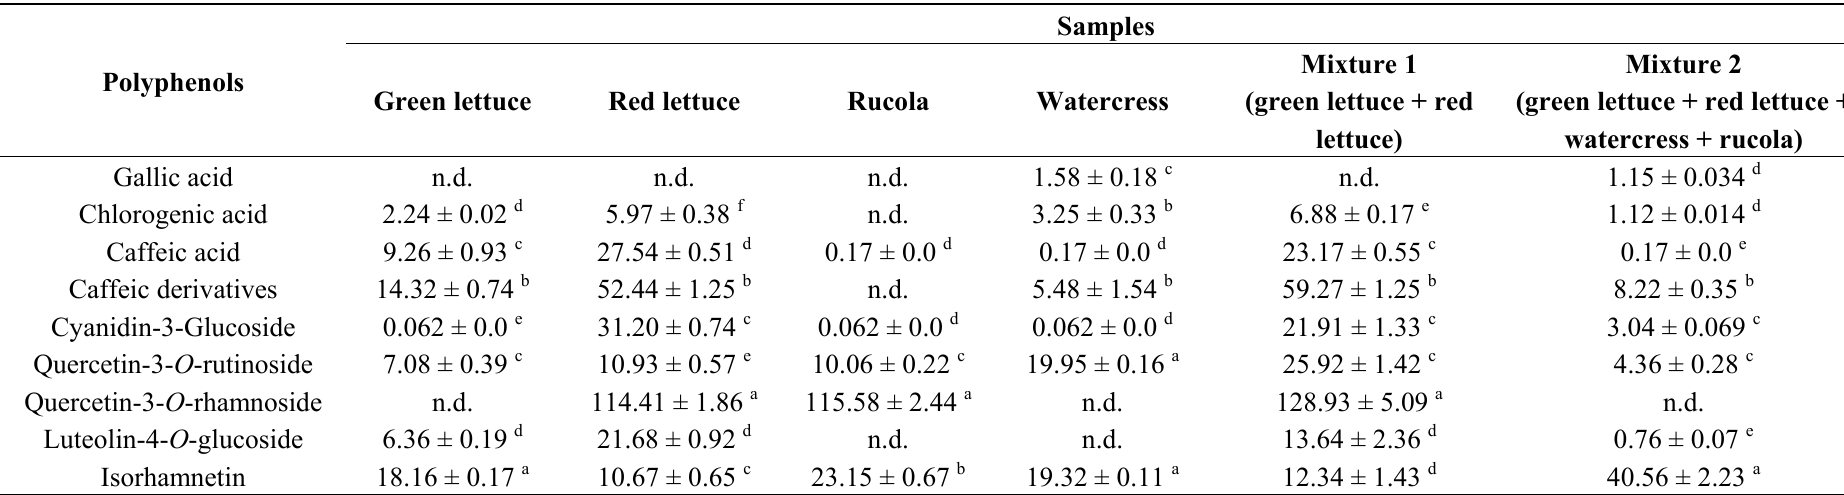
Table 2. Average levels of individual phenolics quantified in baby-leaf salads samples by HPLC, expressed as mg·100 g − 1 DW 1,2,3